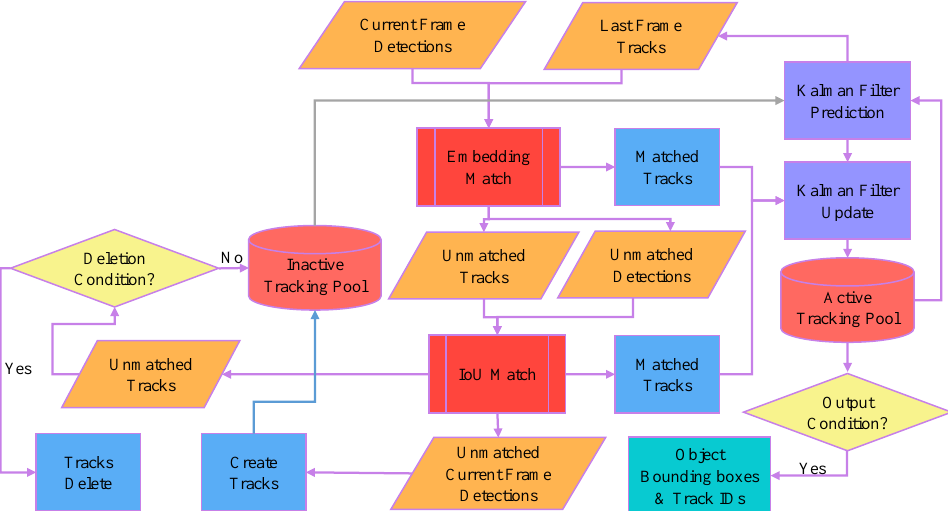
Figure 2. The pipeline of the data association algorithm that has two match steps and a Kalman